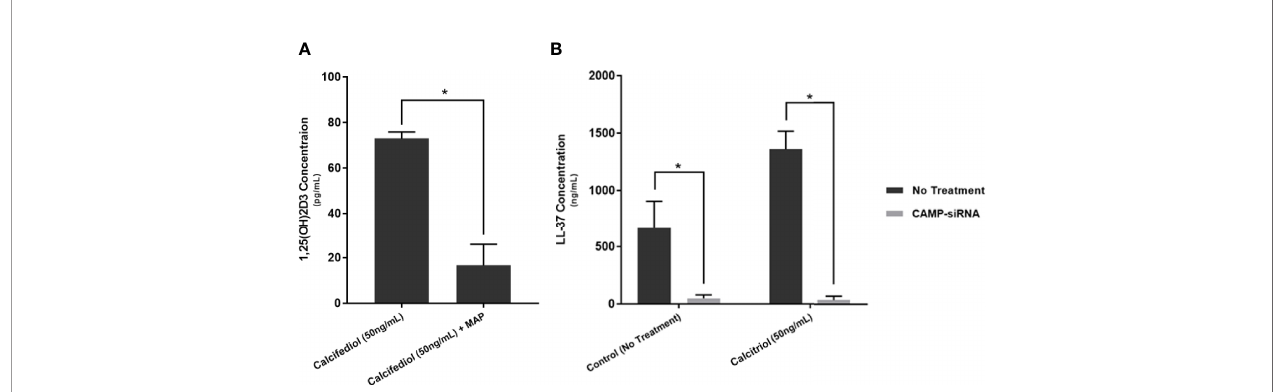
FIGURE 8 | Calcitriol concentration following 24 of treating MAP-infected macrophages with 50 ng/mL of calcifediol (A) , and veri fi cation of successful cathelicidin knockdown by CAMP-siRNA (B) . Values were determined by Calcitriol ELISA Kit (MyBioSource, San Diego, CA) and the Human Cathelicidin Antimicrobial Peptide ELISA Kit (MyBioSource, San Diego, CA). *Indicates P-value of less than 0.05.